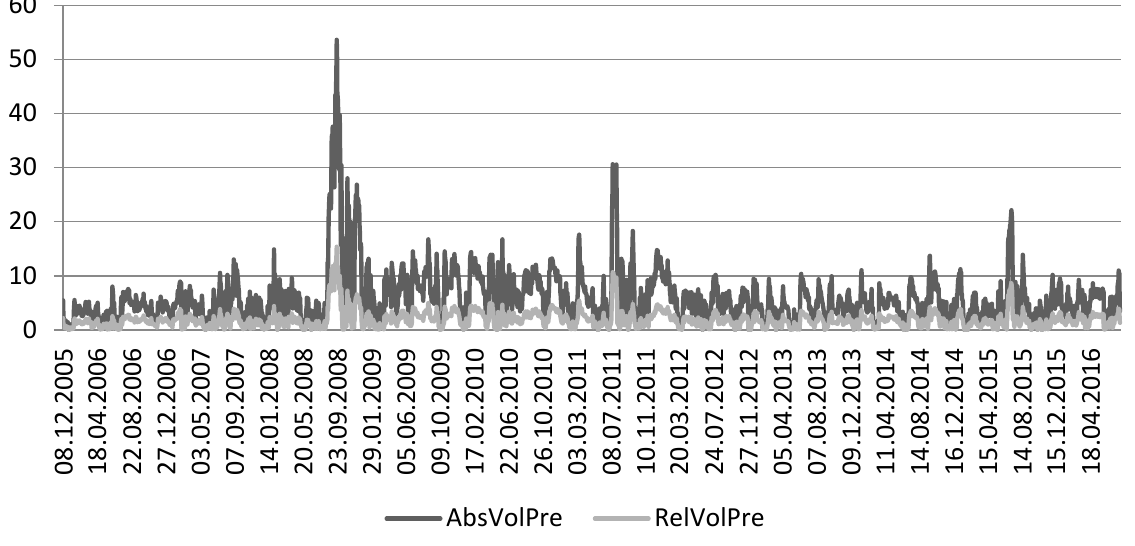
Figure 4. Evolution of absolute and relative